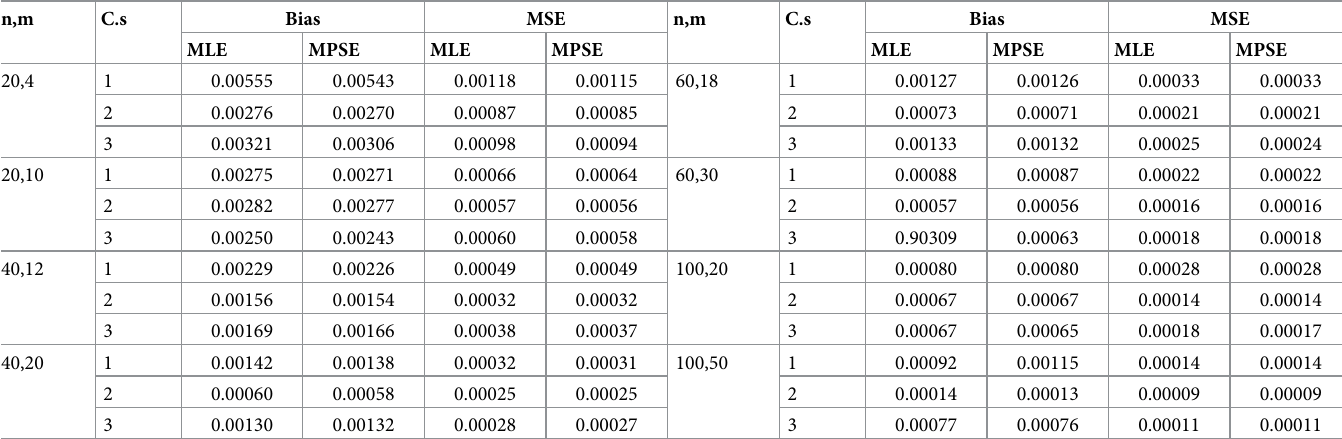
Table 9. Bias and MSE of θ with T 3 = X m +2 for different censoring schemes when θ = 0.9. n,m